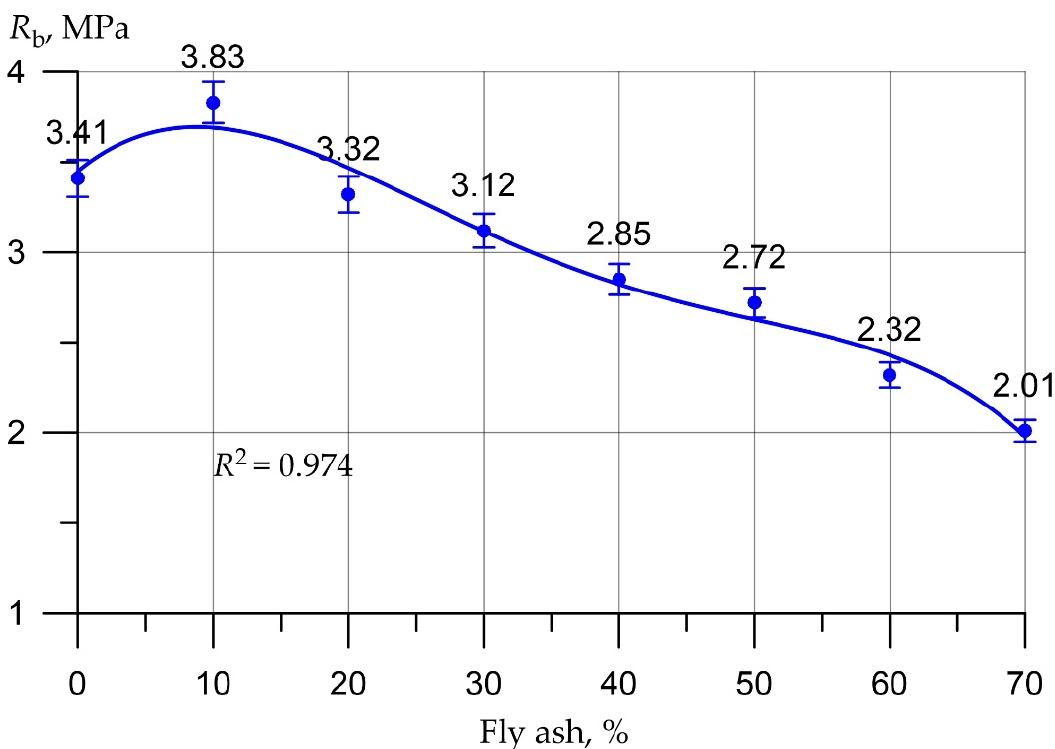
Table 9. Change in CS of FFC samples depending on the percentage of FA.